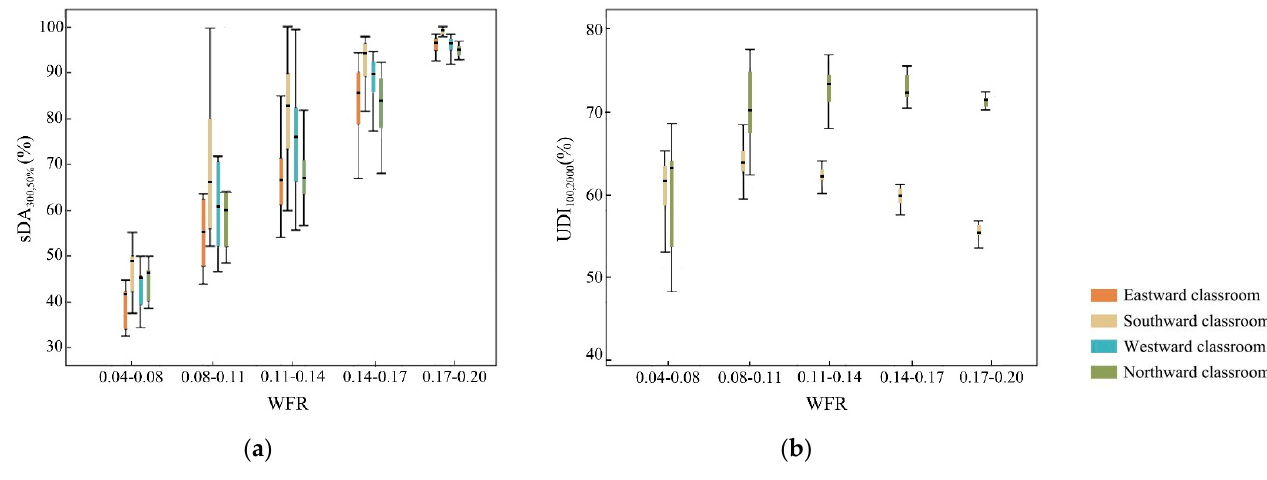
Figure 14. The analysis results of the distribution interval between WFR and the evaluation indices: ( a ) the analysis results of sDA 300,50% ; ( b ) the analysis results of UDI 100-2000